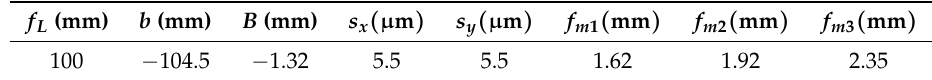
Table 1. Simulated parameters of multi-focus plenoptic camera. ( s x , s y ) stands for the physical size of a pixel in raw image. f m 1 , f m 2 , and f m 3 represent the focal lengths of three types of